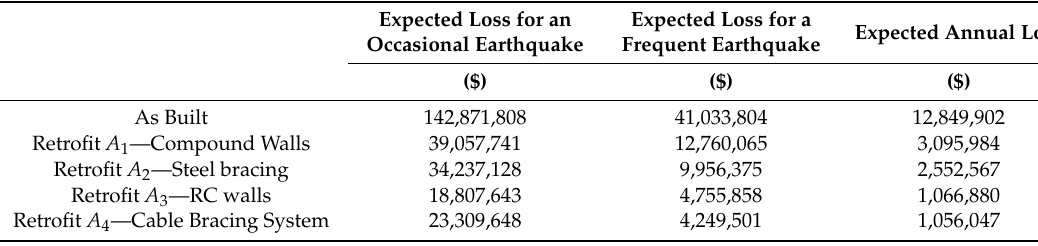
Table 5. Expected Economic